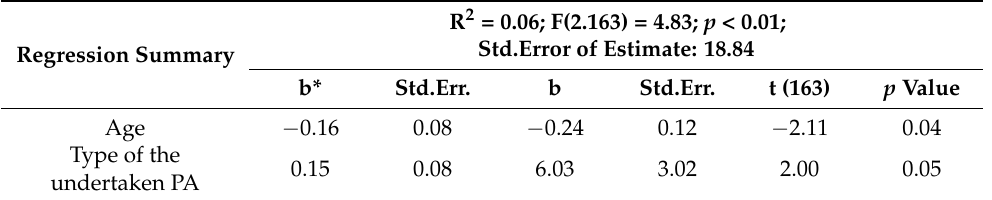
Table 8. Regression summary for the total score achieved in the EDS.